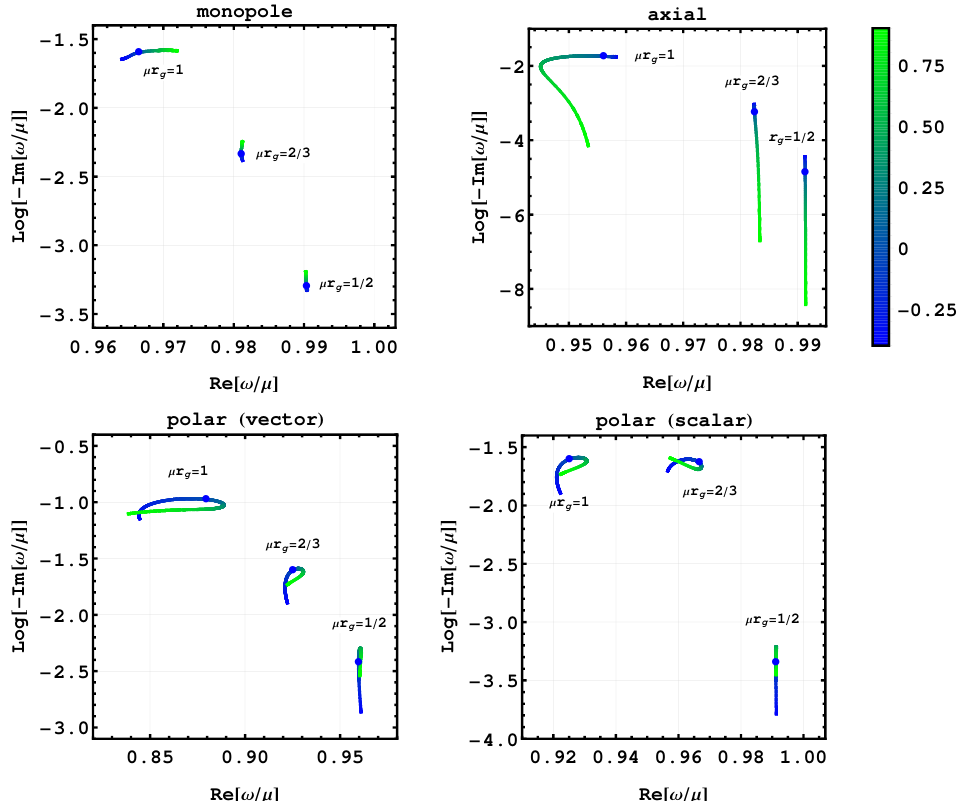
Figure 6 . Behaviour of the fundamental ‘ = 0 , 1 bound states with changing µ and g 6 . For each mode, we present the parametric curves mapped out by − 0 . 4 < g 6 < 0 . 9 (cf. color legend on the right) for three different values of µ × r g = 1 , 2 / 3 , 1 / 2 . The dots indicate the respective value for g 6 = 0 .